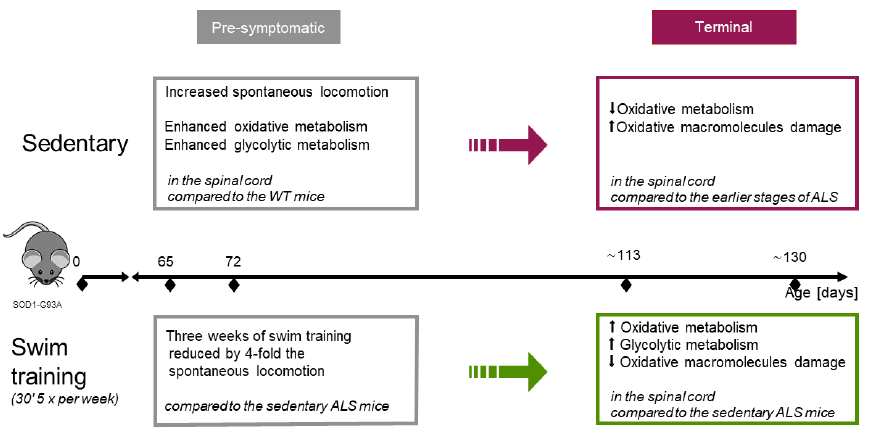
Figure 7. Graphical abstract. ALS disease causes enhanced energy metabolism of the spinal cord. Swim training administrated during the pre-symptomatic phase of ALS causes the reduction of the oxidative stress damage and maintenance of energy metabolism in the spinal cord at the terminal stage of the disease.